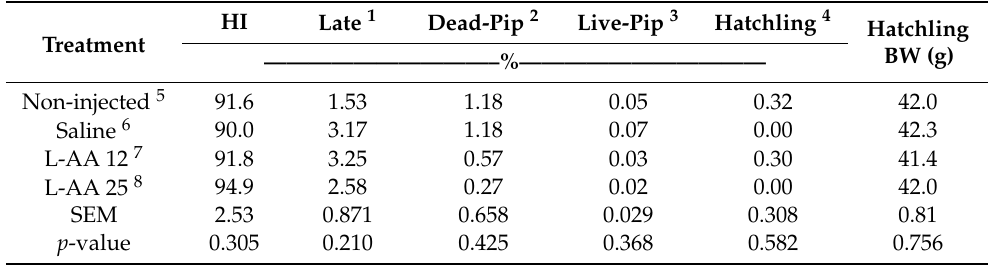
Table 3. Effects of treatment non-injected; saline-injected (saline); saline containing 12 mg of L-ascorbic acid (L-AA 12), or 25 mg of L-ascorbic acid (L-AA 25) across dietary treatment on hatcha- bility of injected live embryonated eggs (HI), hatchling body weight (BW), and hatch residue analysis variables at 21 days of incubation